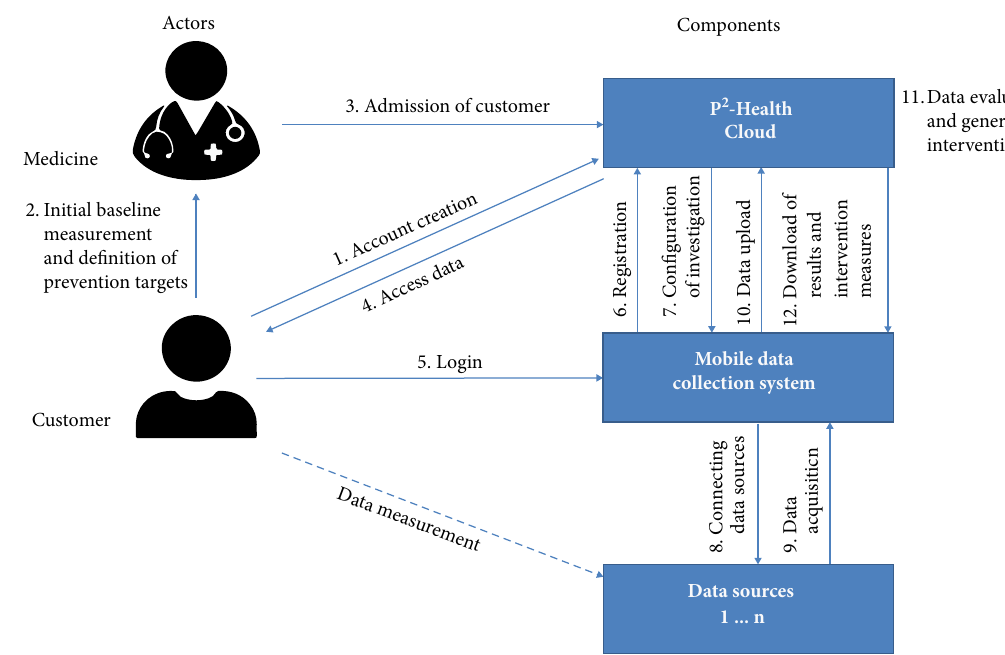
Figure 1: Fundamental concept of the project p 2 Health